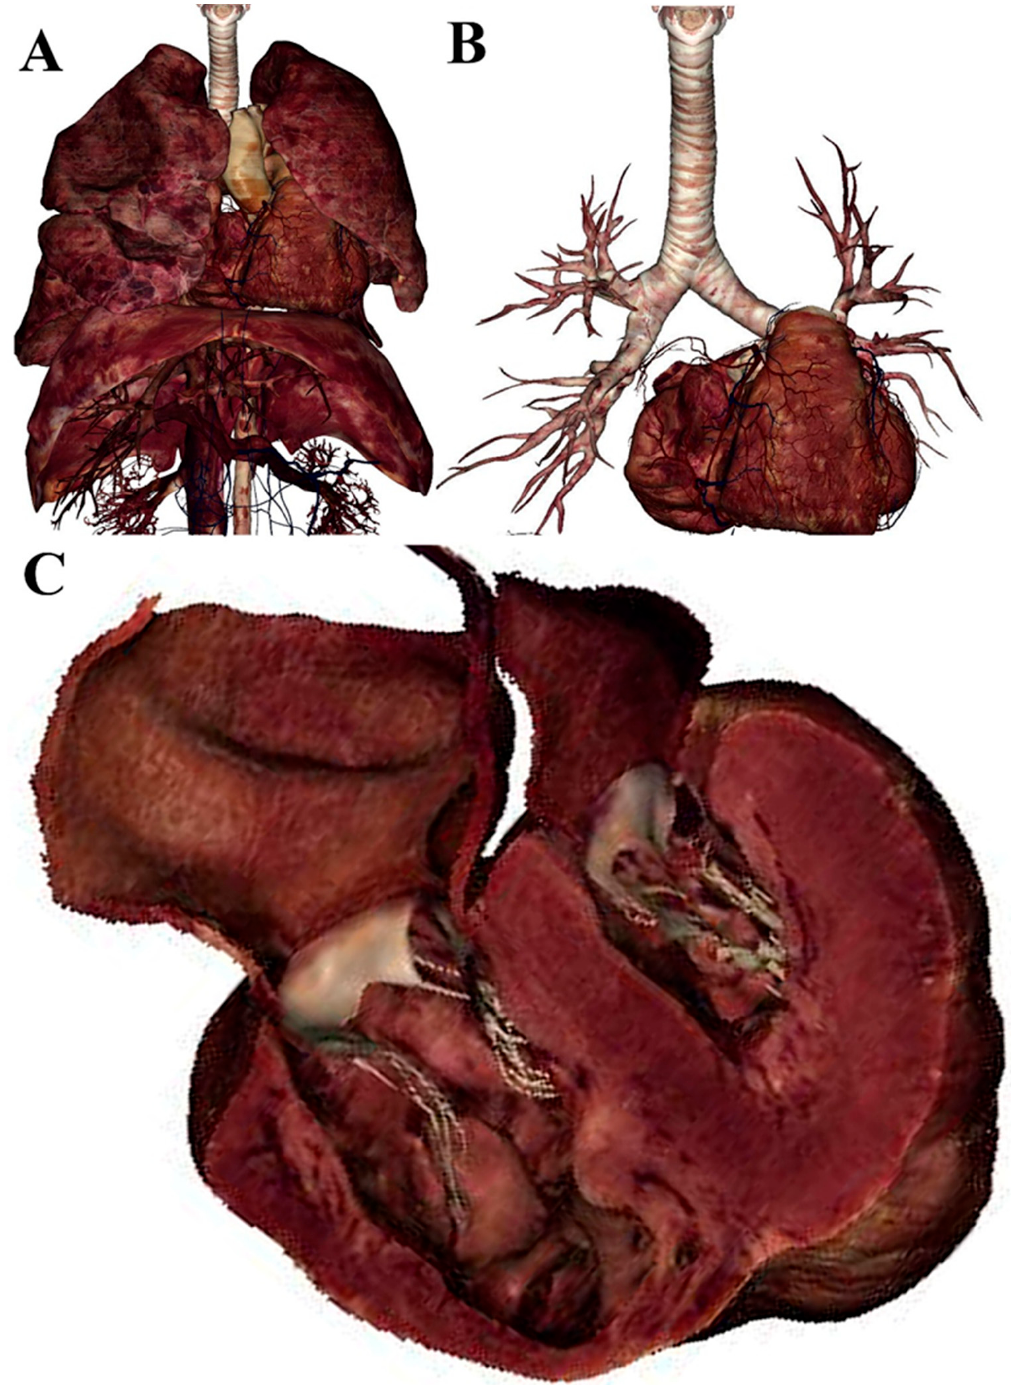
Figure 2. Thoracic region ( A ) of Asian adult man: lungs, heart, aorta, trachea, diaphragm, and the blood vessels of the abdominal region can be observed. The heart, trachea, and bronchial tree can be visualized, while the abdominal region vessels, lungs, diaphragm, aorta were deleted ( B ). In ( C ), a high magnification image of the heart without (a transversal cut was taken) the main vessels appears, in which it is possible clearly to distinguish the ventricular cardiac walls and the atrioventricular